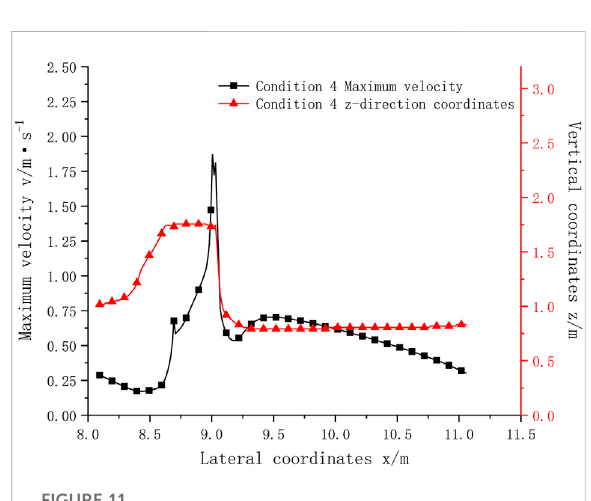
FIGURE 11 Scenario 4 Maximum velocity and position along the